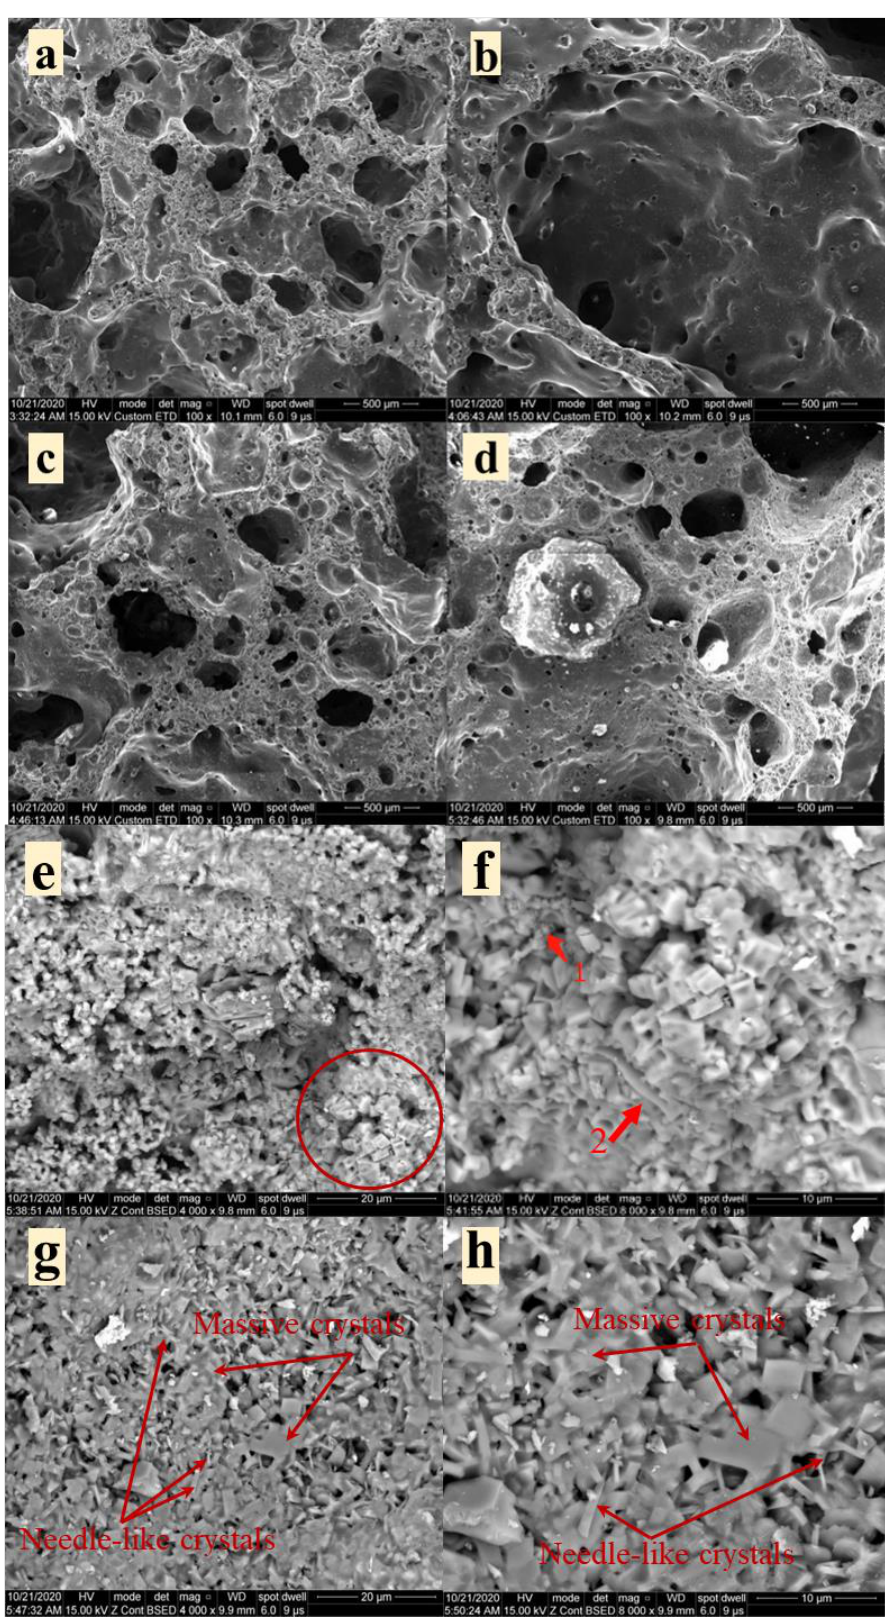
Figure 12. The fracture surface SEM images of ( a ) S6 (1-1), ( b ) 1-2, ( c ) 2-3, ( d ) 3-4 (100×), ( e ) 2-3 (4000×), ( f ) 2-3 (8000×). ( g ) 2-3 (4000×), ( h ) 2-3 (8000×).